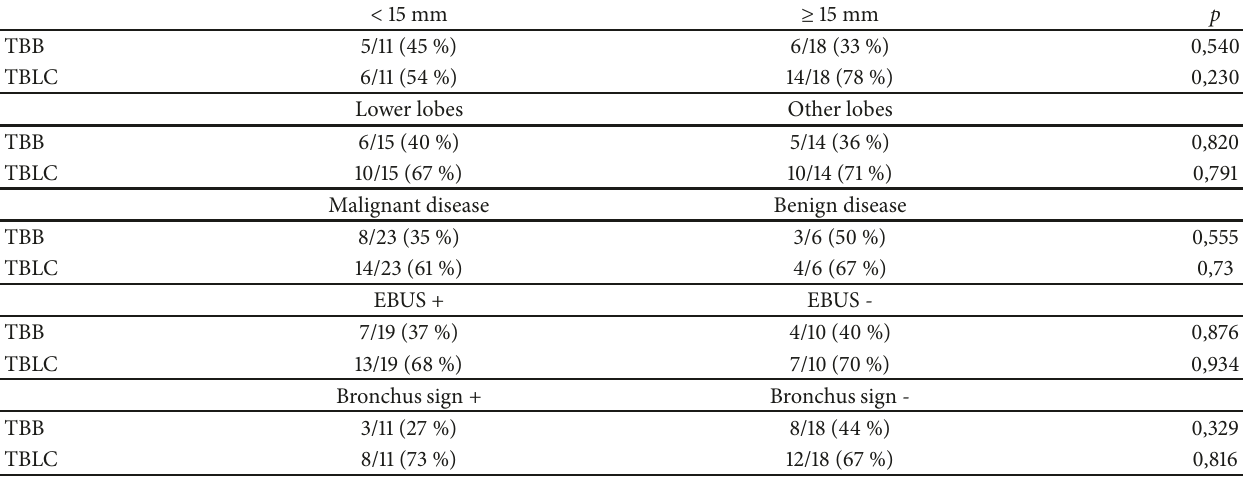
Table 3: Comparison between diagnosis accuracy by TBB and that by